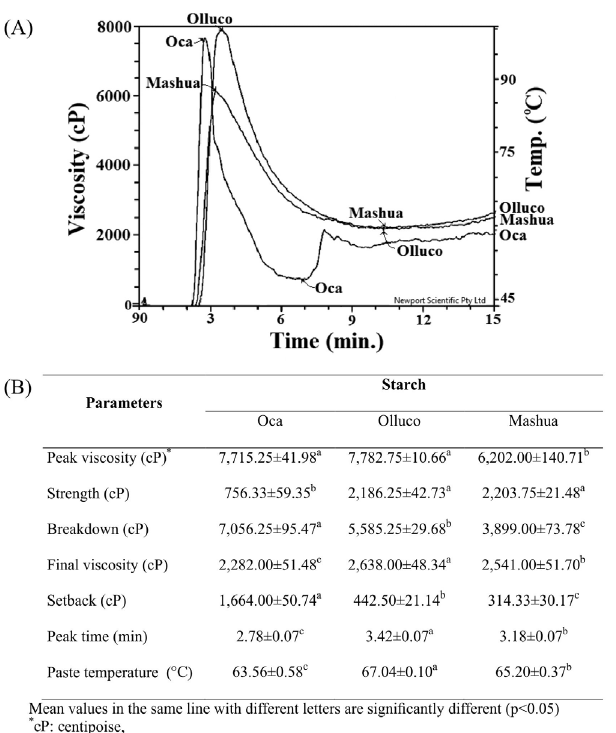
FIGURE 6 - (A) Viscosity profiles from the RVA analysis of oca, olluco and mashua starch pastes; (B) Numeric parameters observed during